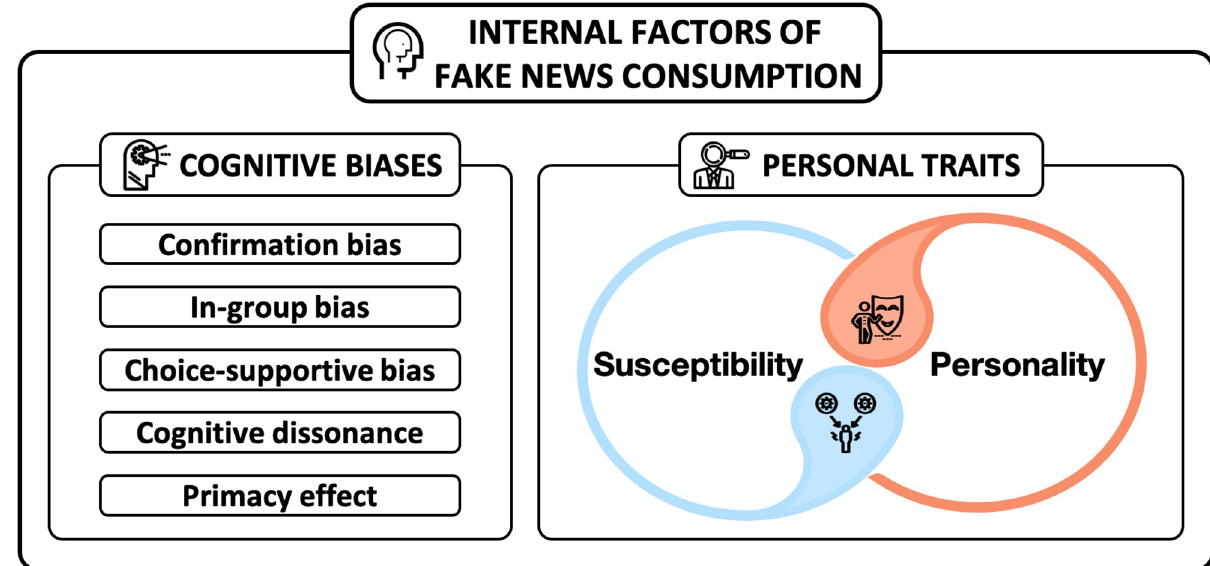
Fig 6. Two internal factors of fake news consumption: Cognitive biases and personal traits.